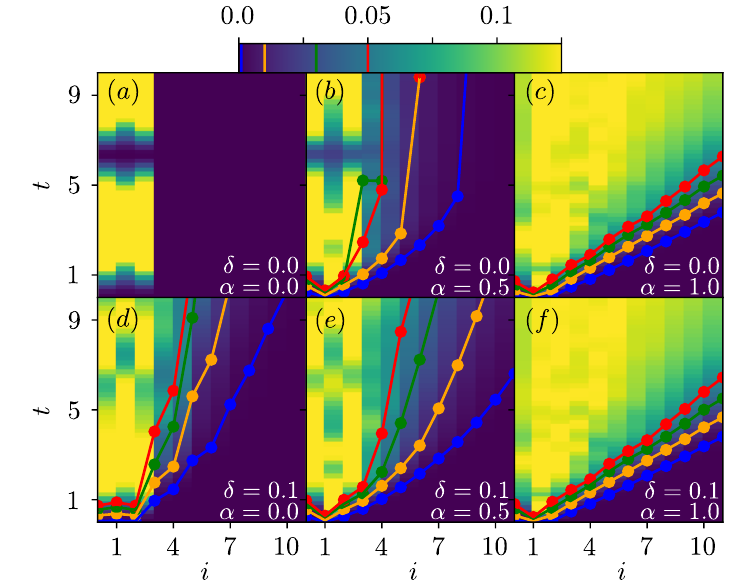
Figure 6: Spacetime evolution of the α -OTOC C α ( i , t ) Eq. (9) for α = 0.0 (a,d), α = 0.5 (b,e) and α = 1.0 (c,f), for δ = 0.0 (a-c), and δ = 0.1 (d-f), L = 12 rungs. The colored lines correspond to contours for thresholds indicated in the